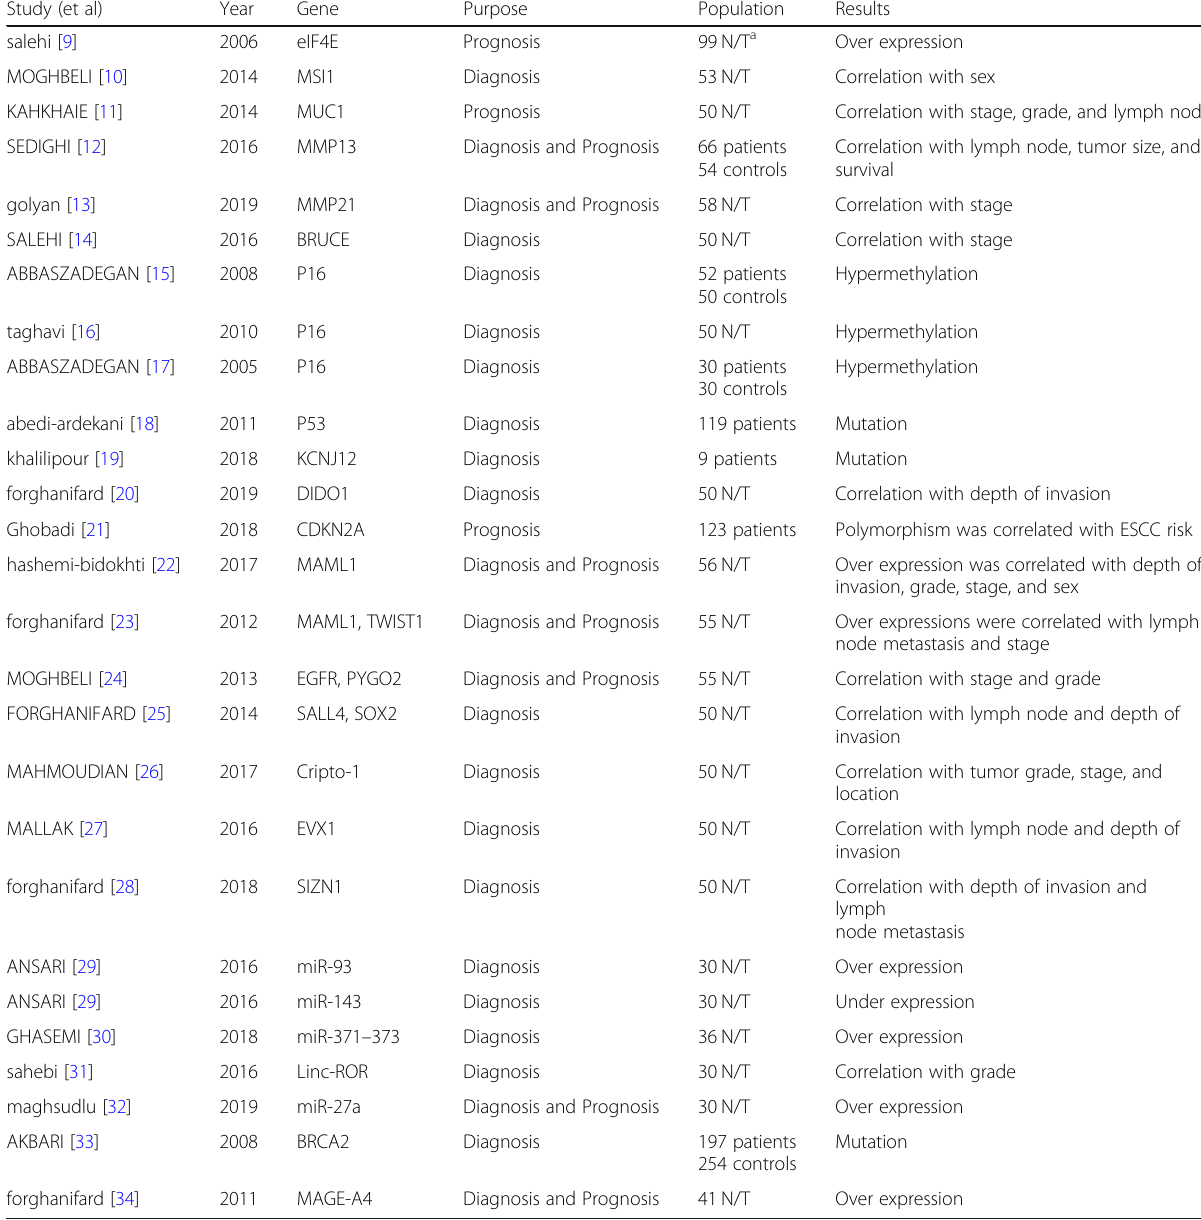
Table 1 All of the involved markers in esophageal cancer susceptibility among the Iranian patients Study (et